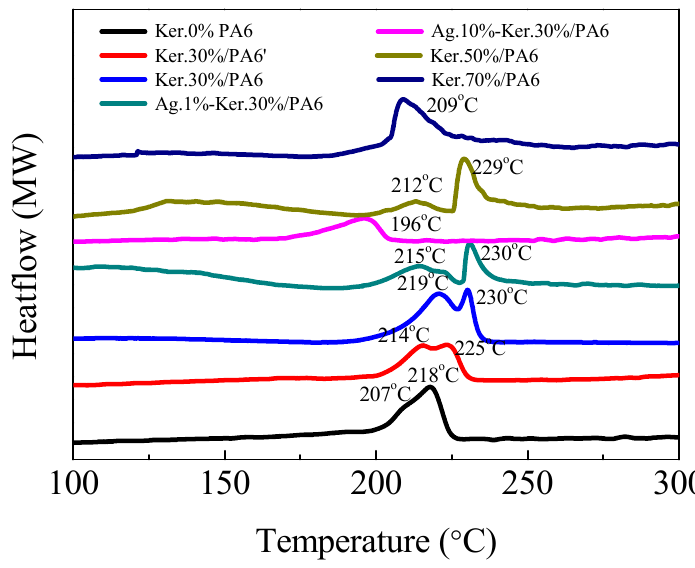
Figure 5. Di ff erential Scanning Calorimetry (DSC) thermograms of di ff erent AgNPs and keratin content Figure 5. Differential Scanning Calorimetry (DSC) thermograms of different AgNPs and keratin content of PA6 composite nanofiber films. of PA6 composite nanofiber